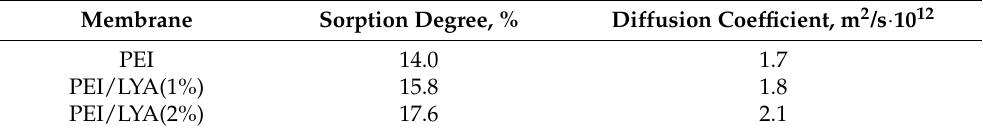
Table 5. The sorption degree and diffusion coefficient of methanol for the PEI/LYA membranes. Membrane